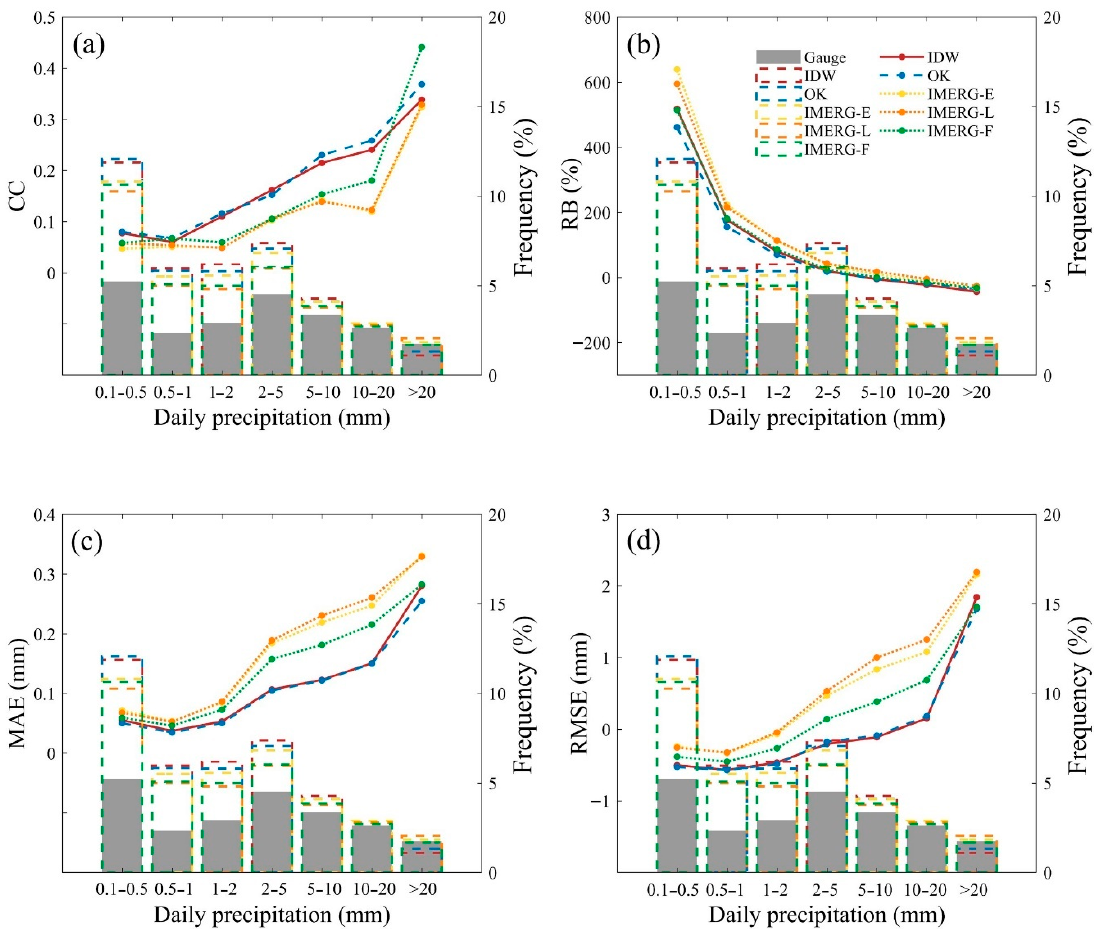
Figure 7. Variations in statistical metrics across increasing precipitation intensities: ( a ) Pearson correlation coefficient (CC), ( b ) relative bias (RB), ( c ) mean absolute error (MAE), and ( d ) root mean square error (RMSE). Columns in the right axis present the frequency of precipitation estimated from gauge stations, interpolation methods, and IMERG SPPs.